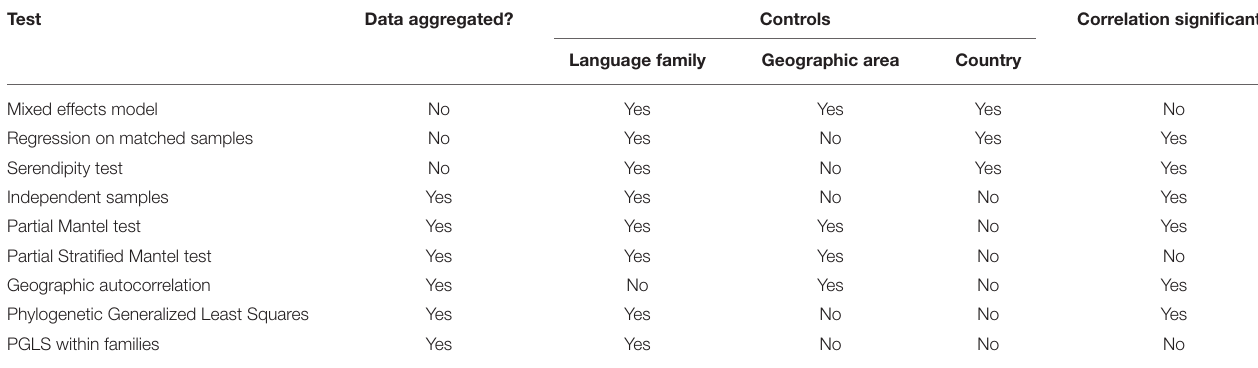
TABLE 1 | Summary of the statistical tests in Roberts et al. (2015) relating future tense to economic choices.